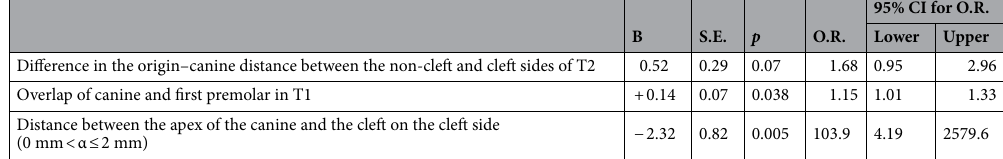
Difference in the origin–canine distance between the non-cleft and cleft sides of